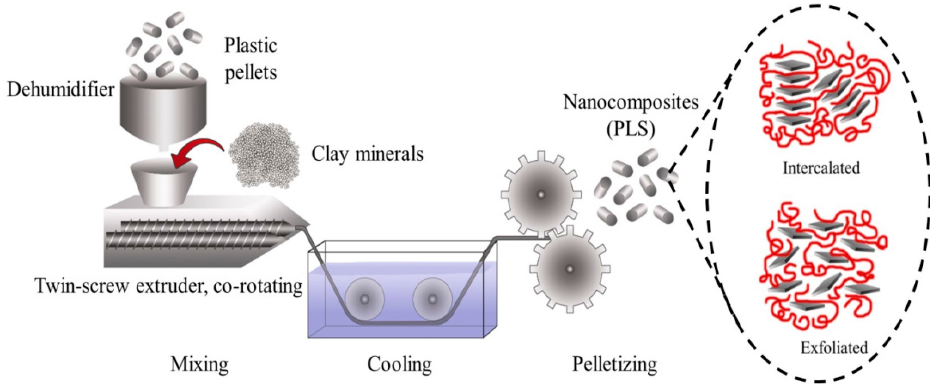
Figure 3. Schematic representation for preparing polymer nanocomposites by melt blending (taken from [37]).